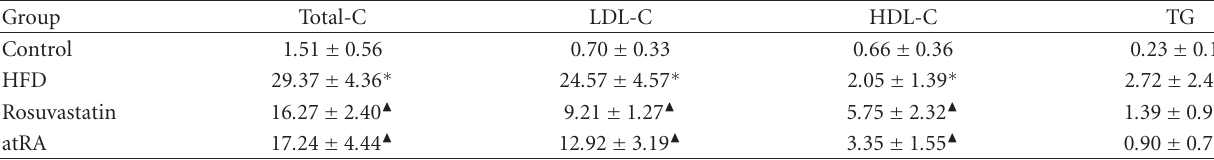
Table 1: Levels of plasma lipids in di ff erent groups (mmol/L).